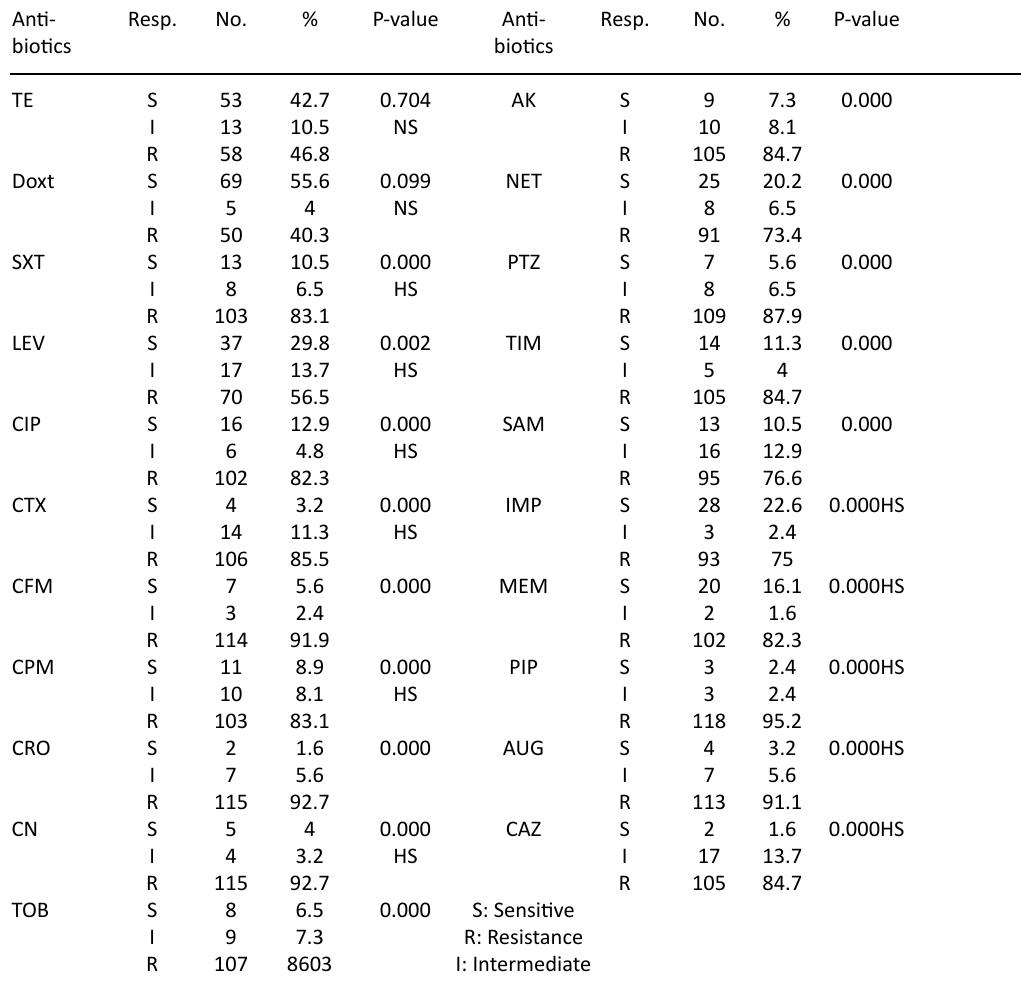
Table 1. Significance and Antibiotic groups distribution according to the number and percentage of resistance Anti- Resp. No. % P-value Anti- Resp. No. %